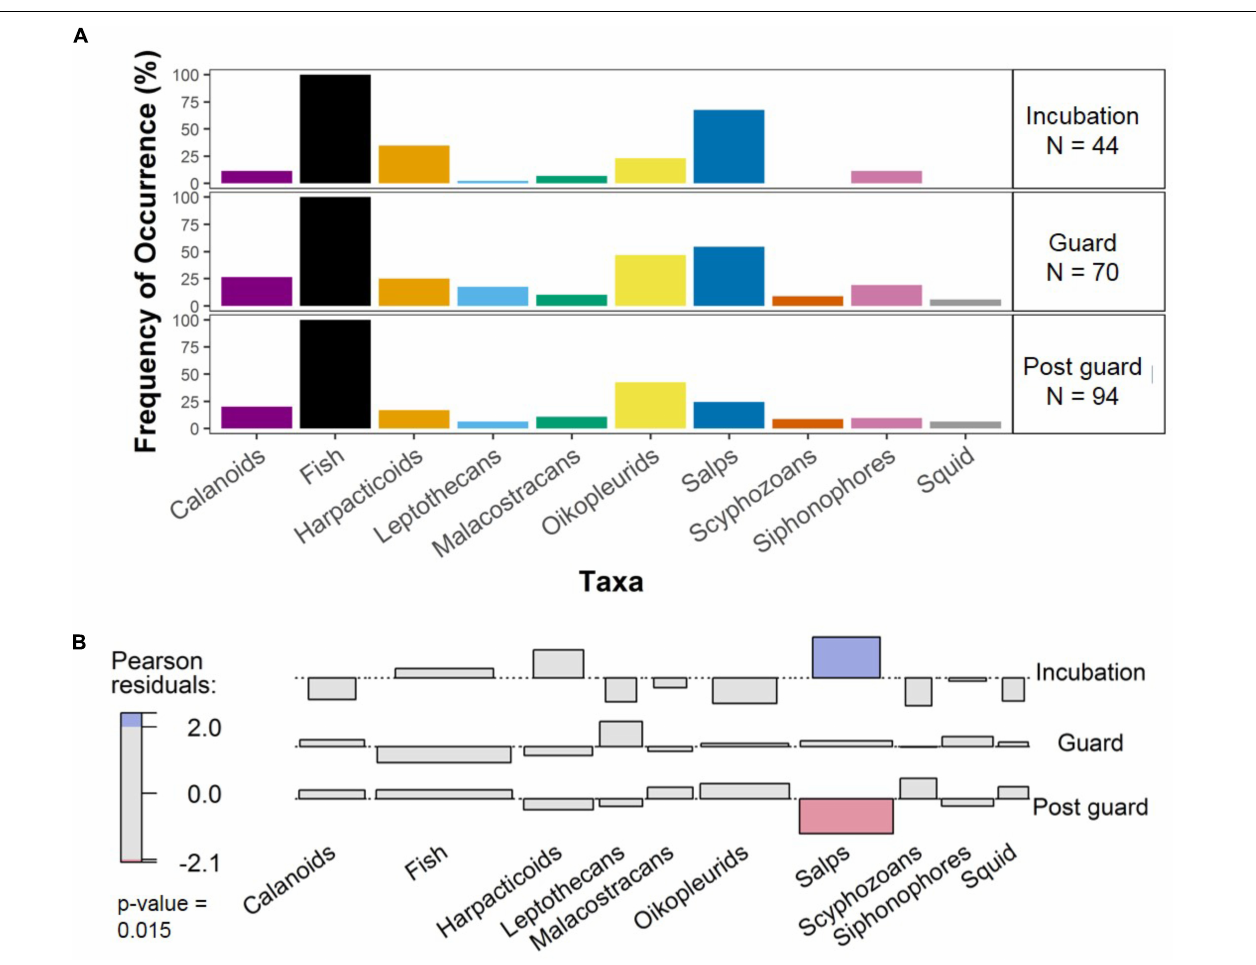
FIGURE 4 | The frequency of occurrence (%) of the 10 most common taxa in fecal samples over breeding stages. The percentages for each taxon over breeding stages are shown along with number of samples per stage (A) and the association plot (B) illustrates significant differences between observed and expected numbers of samples containing taxa at each breeding stage, based on Pearson residuals. Red or blue shading indicates significance level. Light shading indicates p -values between 0.05 and 0.01, while bold shading indicates p -values < 0.01. In our analysis, we have accepted only significant values less than 0.01. Note that January was not incorporated in analyses due to insufficient sample